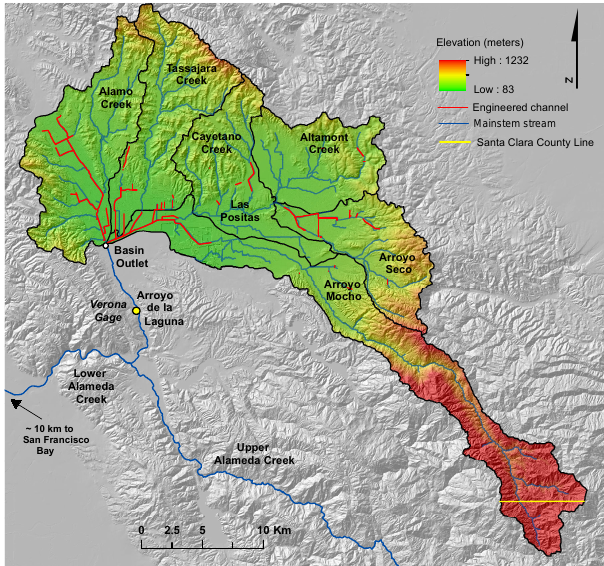
Figure 1. Arroyo Mocho watershed showing the six major basins, mainstem channels, and flood control